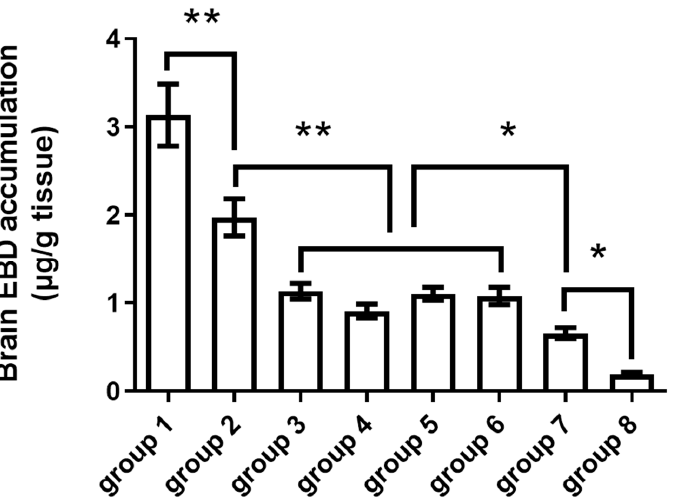
Figure 5. Duration of BBBD. The degree of BBBD was the greatest immediately after sonication, BBBD effect lasts for 6 h. * Indicates p < 0.05, ** indicates p < 0.01. Group 1: EBD injection after sonication 0 h ( n = 9); Group 2: EBD injection after sonication 0.5 h ( n = 12); Group 3: EBD injection after sonication 1 h ( n = 9); Group 4: EBD injection after sonication 2 h ( n = 9); Group 5: EBD injection after sonication 3 h ( n = 9); Group 6: EBD injection after sonication 4 h ( n = 9); Group 7: EBD injection after sonication 6 h ( n = 3); Group 8: EBD only, no sonication ( n =